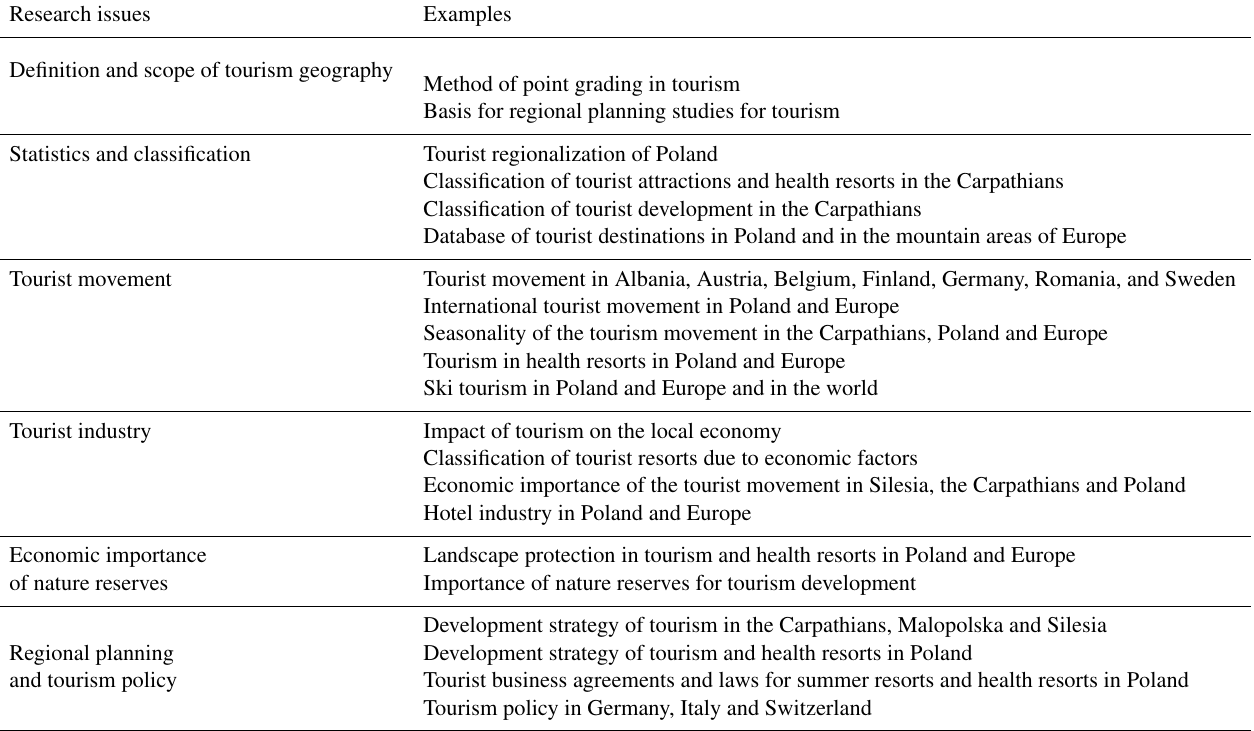
Table 2. Research issues of the Jagiellonian University School of Tourism (source: authors’ own work based on archival materials of the